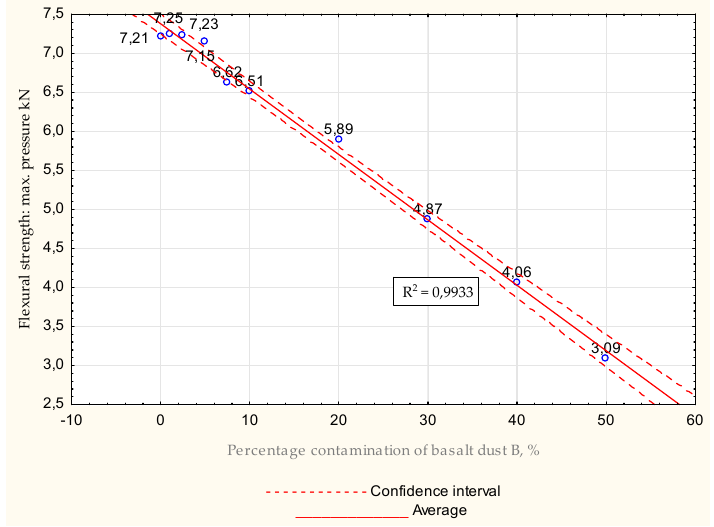
Figure 32. Average values obtained during flexural strength tests after 28 days for water − mix ratio = 0.6, maximal pressure.